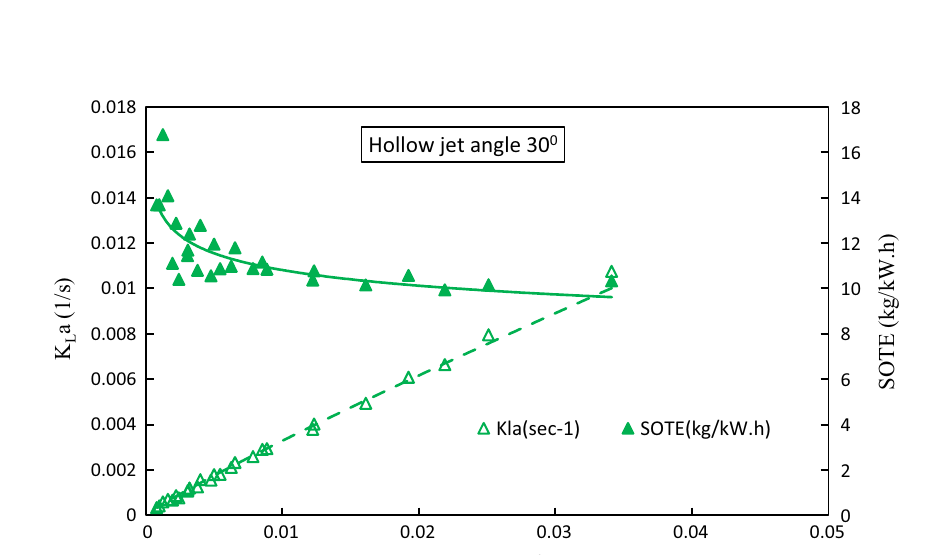
Fig. 6 K L a and SOTE as a func- tion of kinetic jet power per unit volume ( P / V ) of water ( θ =